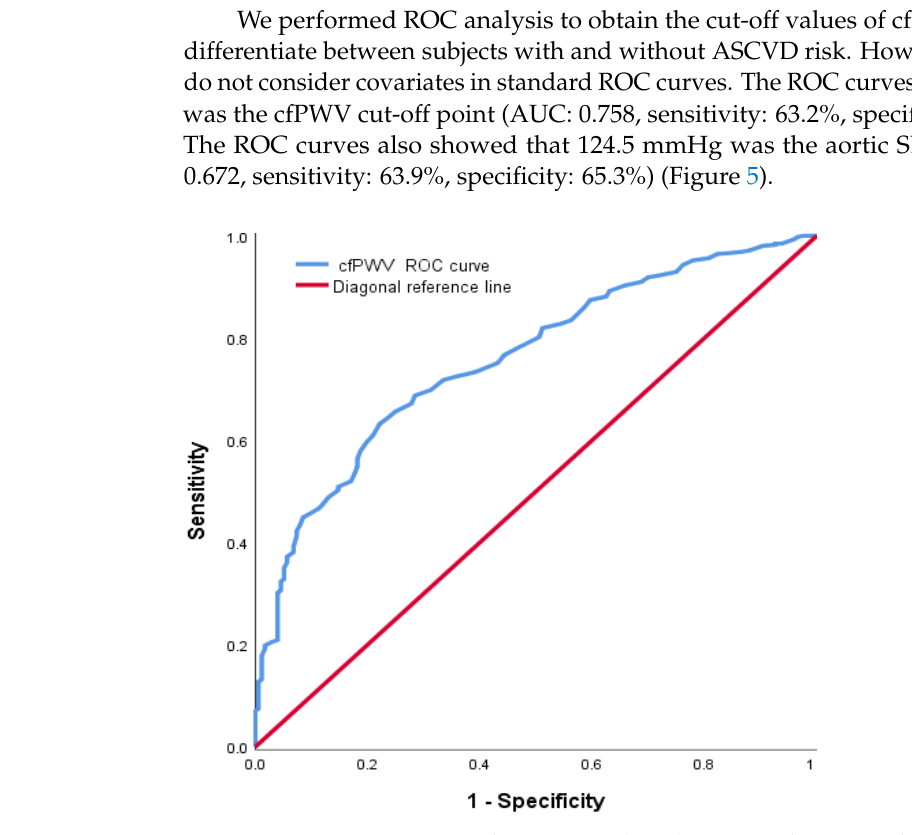
Figure 4. Receiver operating characteristic (ROC) curve to determine the cut-off value of carotid- femoral pulse wave velocity for risk of ASCVD. The cut-off point of 12.45 m/s showed a sensitivity of 63.2%, a specificity of 77.8%, and an area under the curve (AUC) of 0.758.